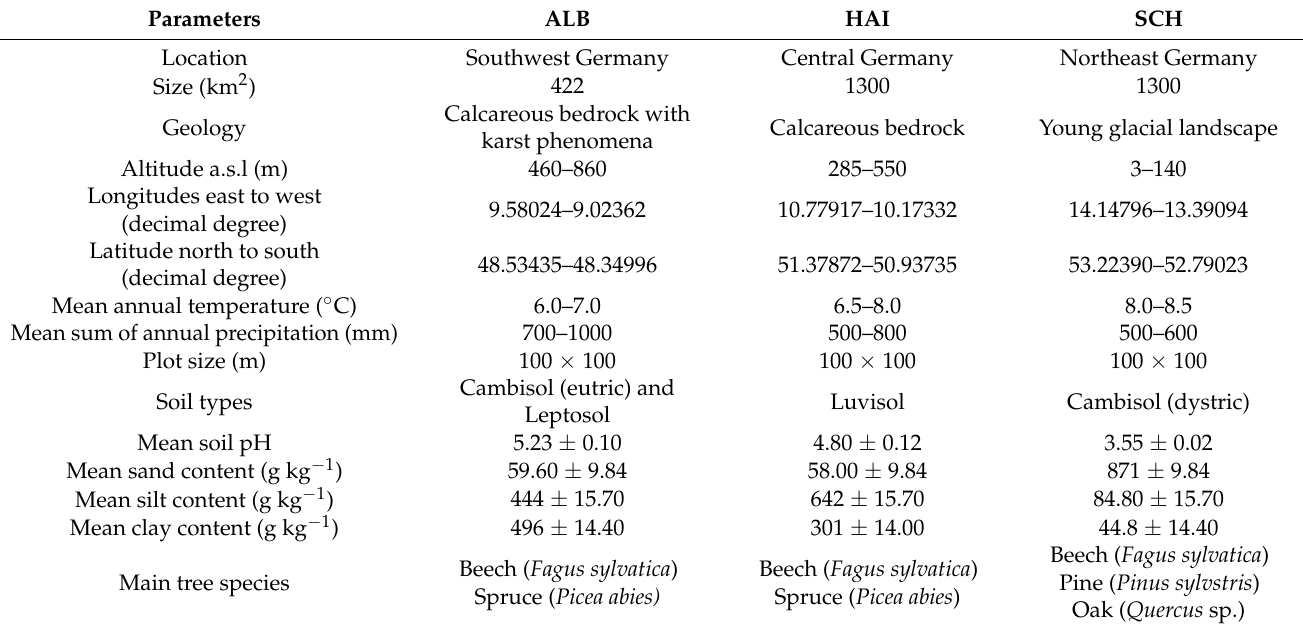
Table 1. Key site characteristics of the three biogeographic regions in the Biodiversity Exploratories. Schwäbische Alb = ALB, Hainich-Dün = HAI and Schorfheide-Chorin = SCH. Data were compiled from [20,34–36,38].